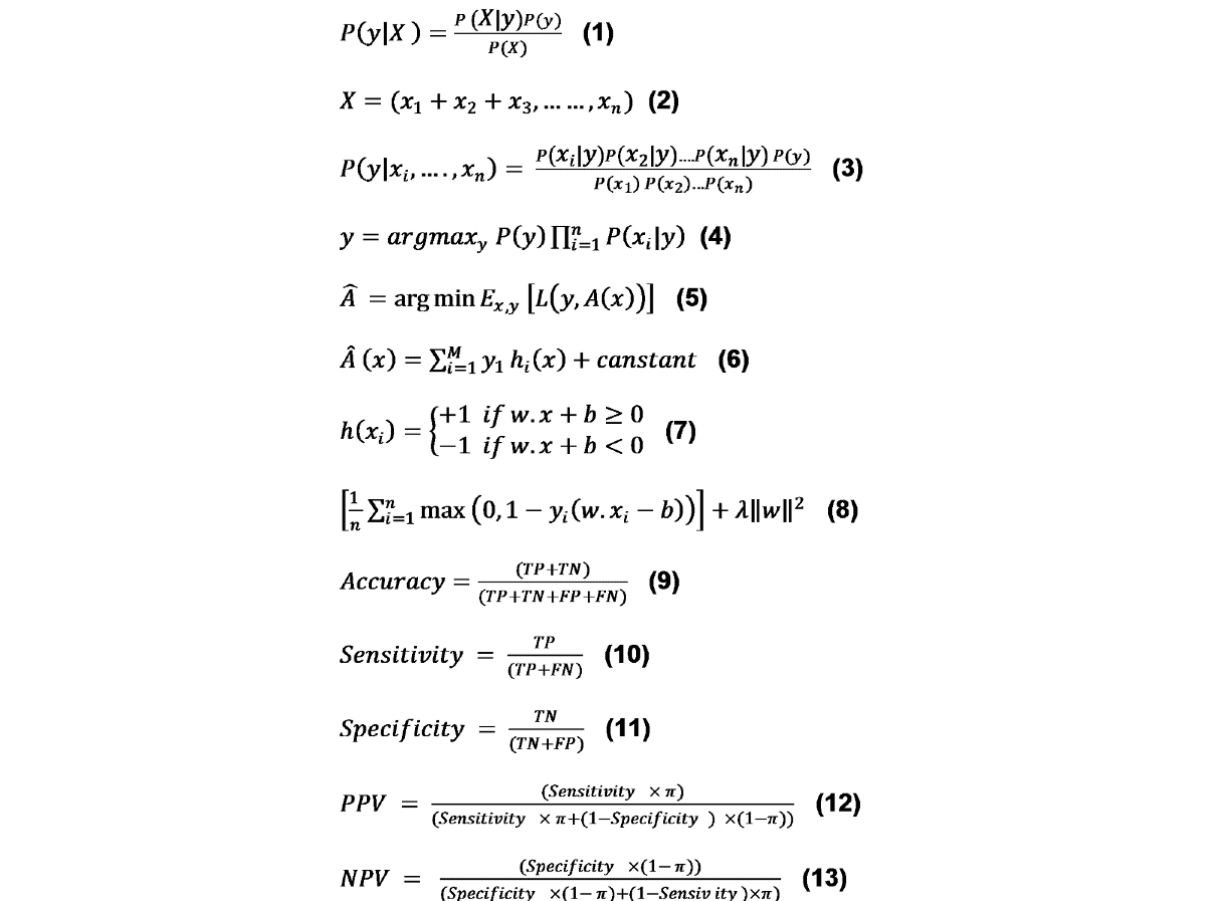
Figure 3. Equations. FN: false negative; FP: false positive; NPV: negative predictive value; PPV: positive predictive value; TN: true negative; TP: true